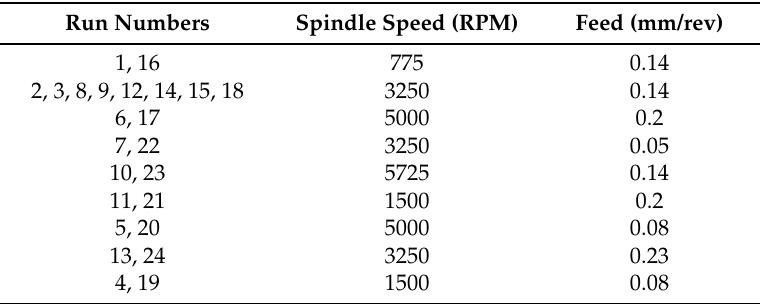
Table 1. Central composite design for the drilling experiments.